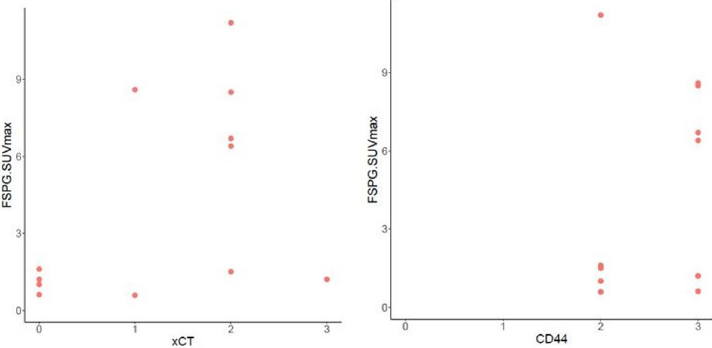
Fig 2. 18 F-FSPG SUVmax correlation with xCT (spearman correlation 0.440, p = 0.153) and CD44 (spearman correlation 0.172, p = 0.594) in cancer cases.